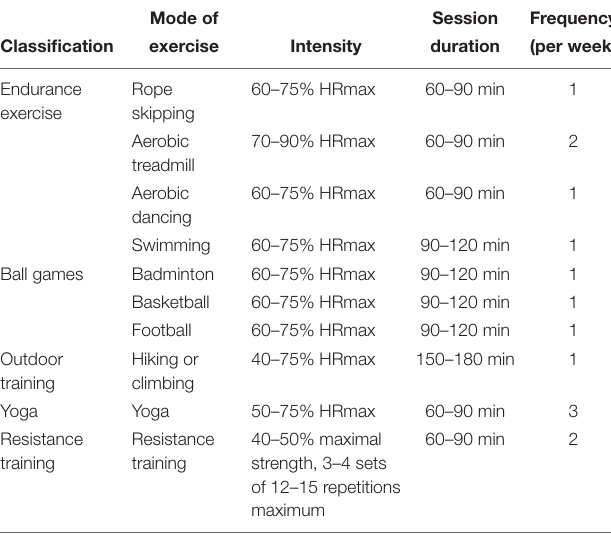
TABLE 1 | Summary of the 6-week exercise training